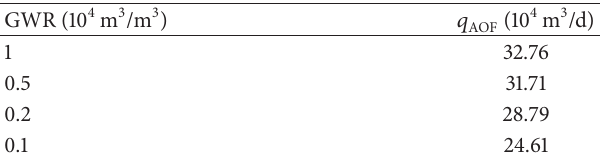
Table 3: The absolute open flow rates in different production gas water